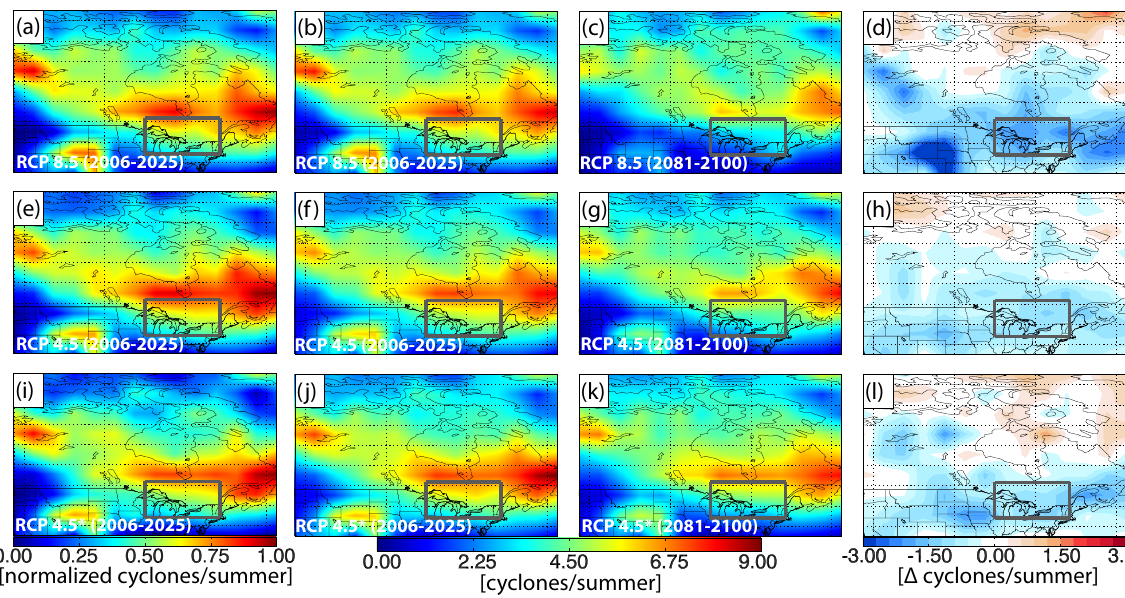
Fig. 6. Spatial distribution of GFDL CM3 cyclone tracks during JJA. Left column (a, e, i) shows the normalized base period (2006–2025), middle left column (b, f, j) shows the base period (2006–2025), middle right column (c, g, k) shows the future period (2081–2100), and the right column (d, h, l) is the difference (Future − Base). First row (a, b, c, d) is the RCP 8.5 scenario, second row (e, f, g, h) is RCP 4.5 ensemble mean, and the third row (i, j, k, l) is RCP 4.5 ∗ (Table